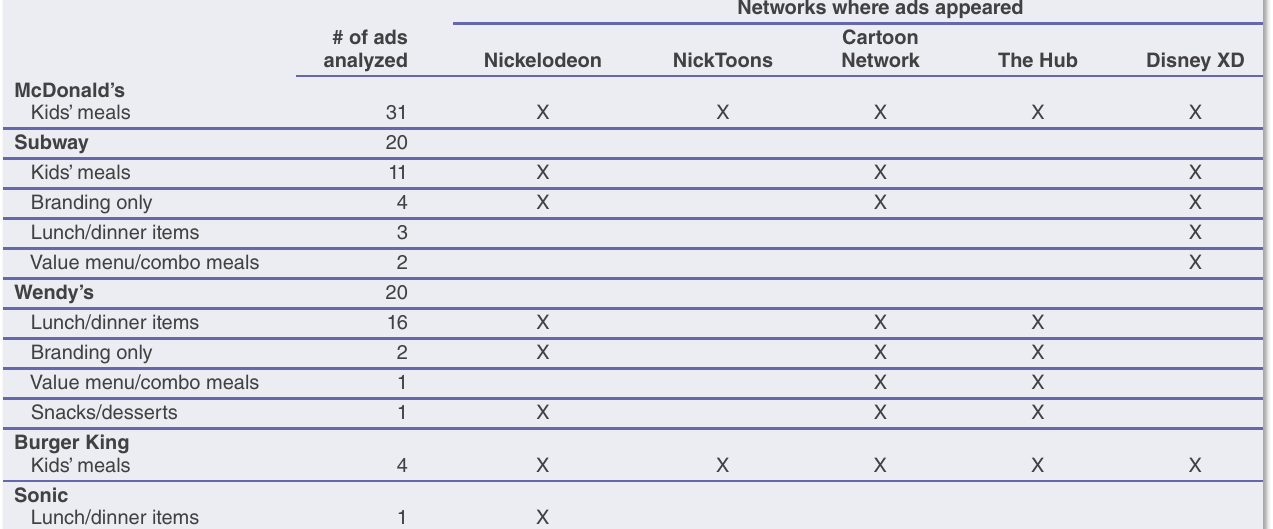
Table 19. Product types advertised on children’s